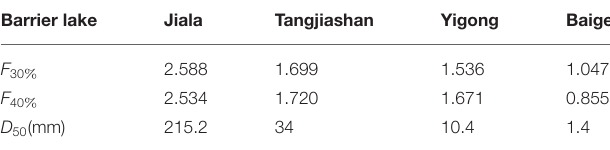
TABLE 3 | The symmetry parameter of four typical barrier lake outburst